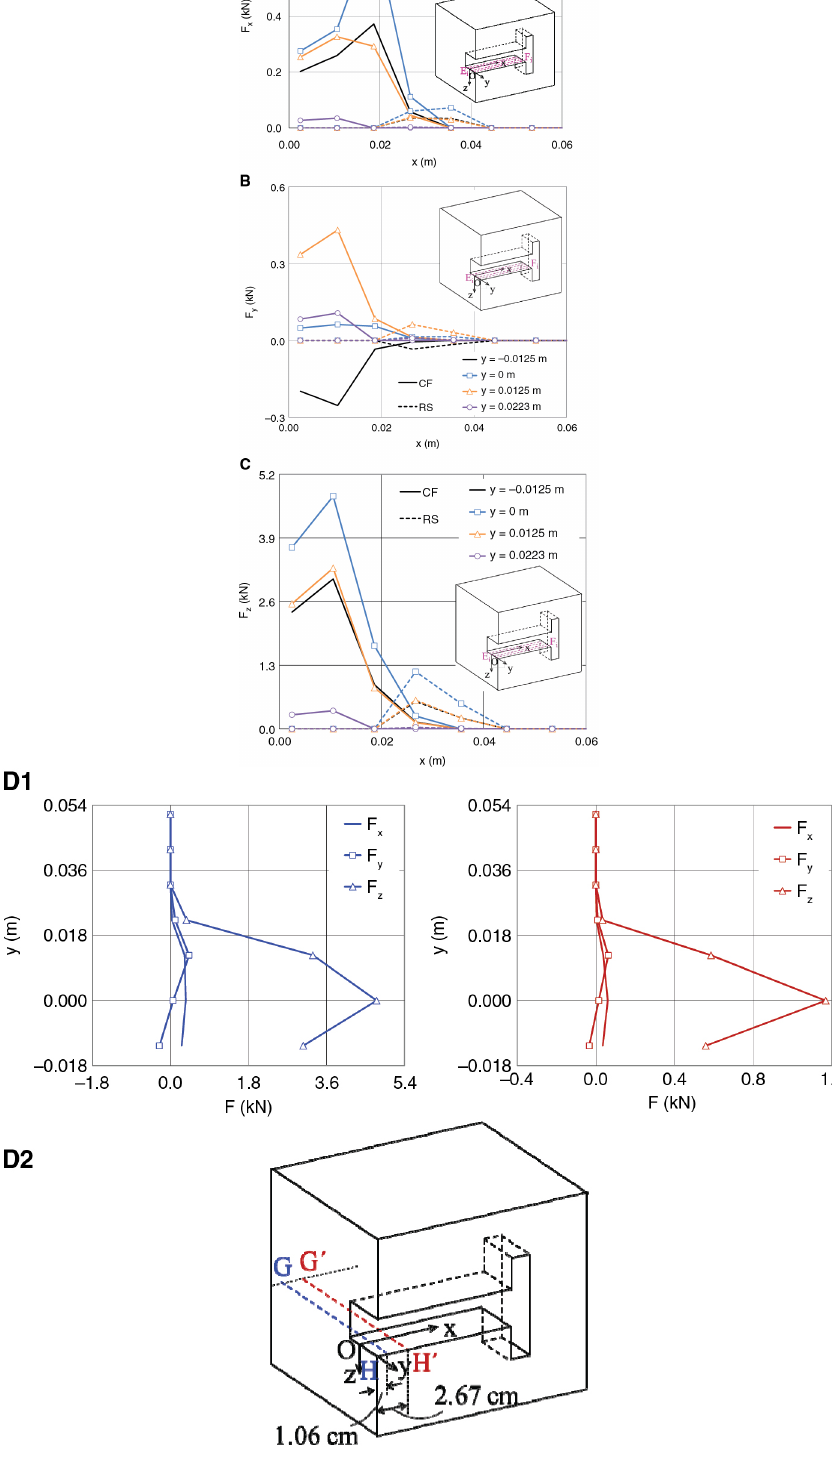
Figure 12: The variation of the force components, i.e. (A) F lines E F (i = 1, ..., 4). (D) The variation of the force components along depth of the i i